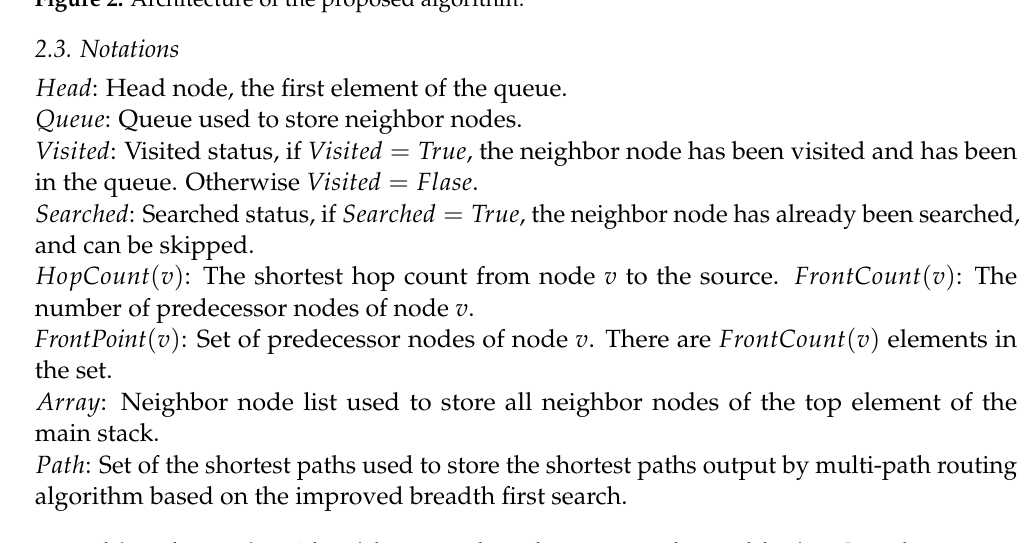
Figure 2. Architecture of the proposed algorithm.